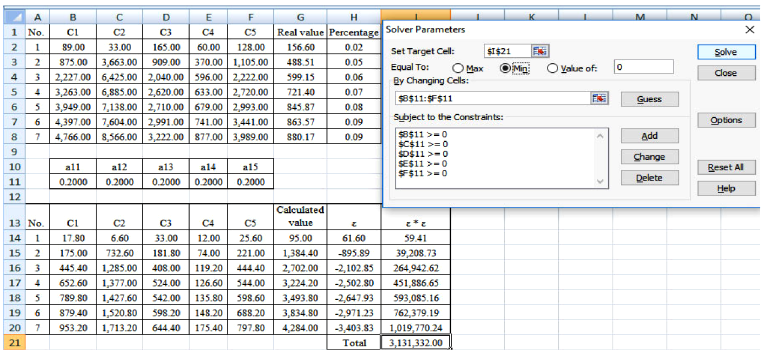
Figure 2. Spreadsheet for determining unknown parameters using the Solver module In the calculation, cell I21 contains the sum of the squares of the errors that is the func- tion for which a minimum is searched. Solver values for unknowns are: a